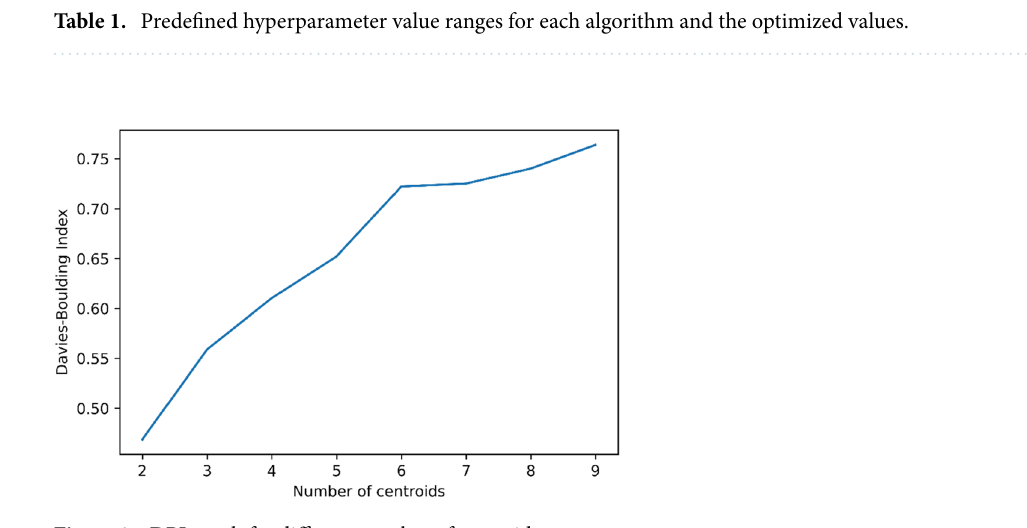
Figure 3. DBI graph for different number of